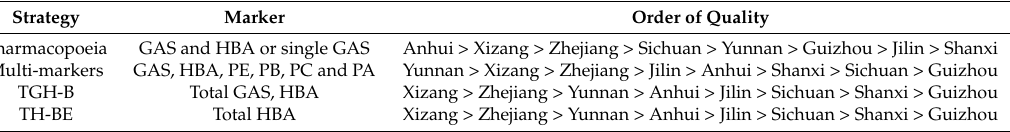
Table 4. Comparison of four strategies for quality control of G.